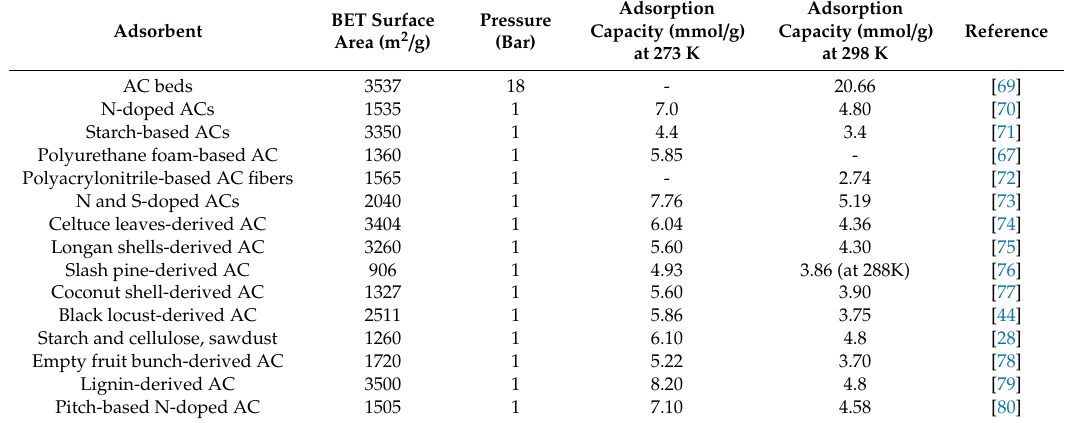
Table 3. CO 2 capture performances by di ff erent activated carbons